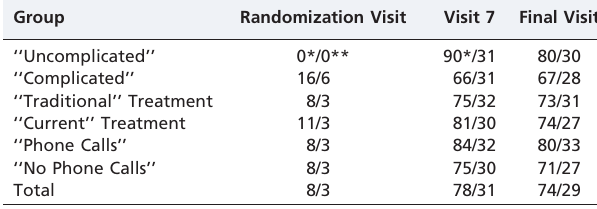
Table 3 - Percentage of patients with controlled blood pressure at the beginning (randomization visit), at the next-to-last visit (visit 7) and at the end (visit 8-final) of the 12-month treatment